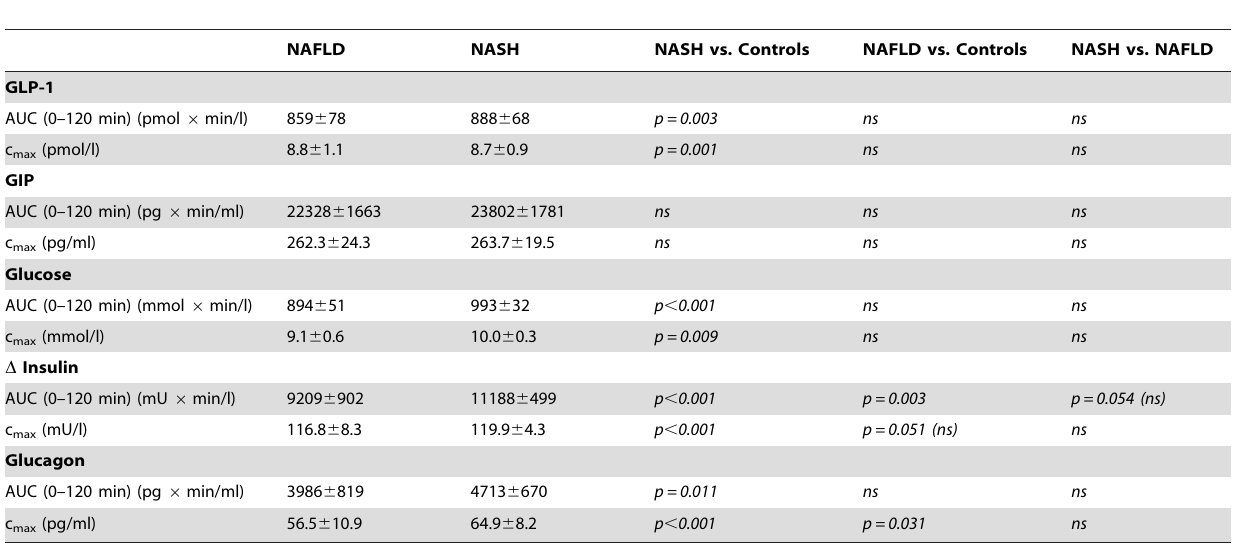
Table 3. Secretion of Glucagon-like peptide-1 (GLP-1), Glucose-dependent insulinotropic polypeptide (GIP), insulin and glucagon and glucose disposal in NAFLD and NASH subgroups vs. controls in response to oral glucose tolerance test.